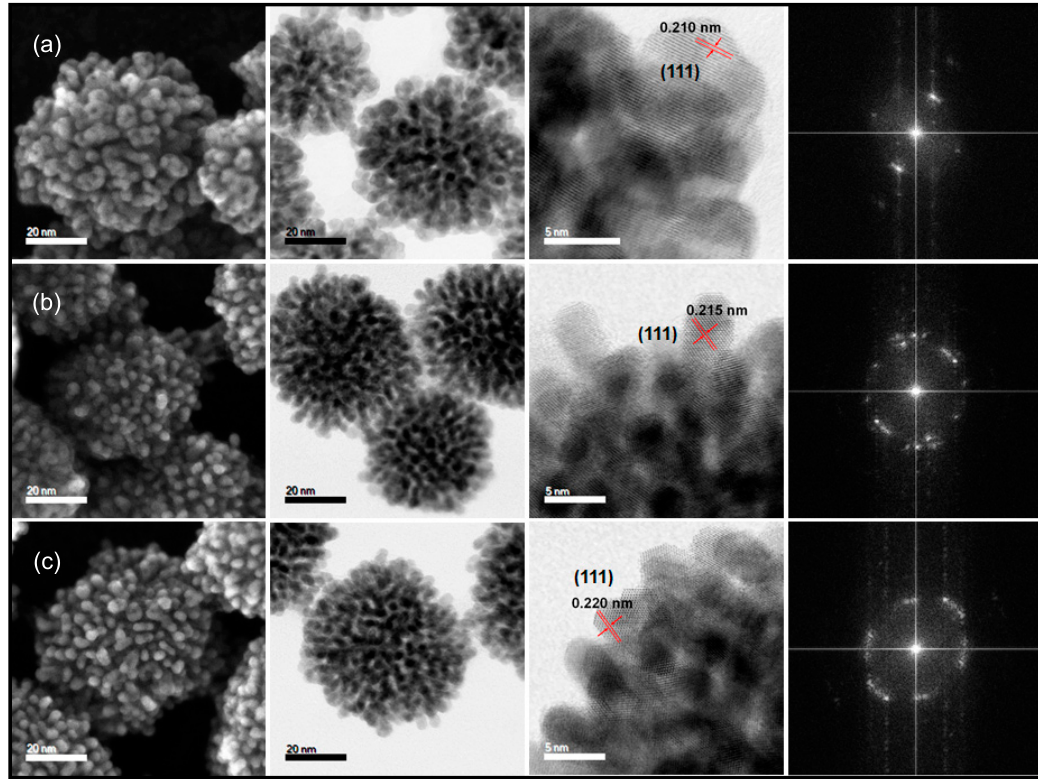
Figure 2. STEM images corresponding to (left to right): secondary electron (SE), bright field (BF), high resolution (HR) BF and FFT diffractograms (generated from the HR-BF images) of the as-synthesized ternary Pt-based nanoalloys with precursor compositions ( a ) Pt 3 (NiCo) 2 ; ( b ) Pt 4 (NiCo); and ( c ) Pt 5 (NiCo). Based on HR-STEM images (( a , b , c ), third column), the measured d -spacings are 0.210 nm, 0.215 nm and 0.220 nm, respectively.